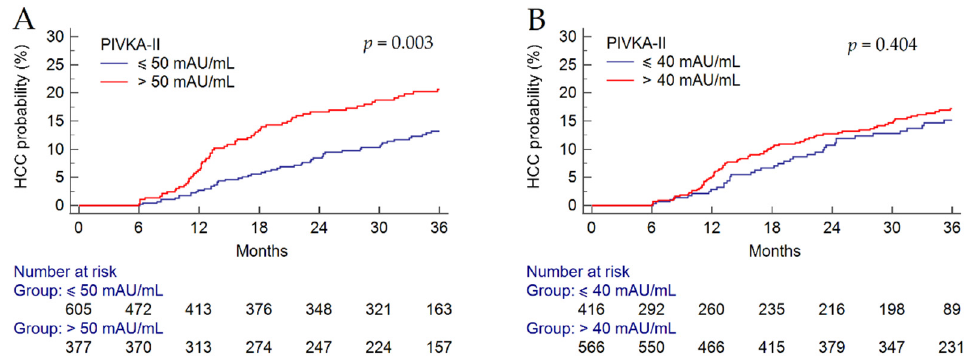
Figure 4. HCC incidence in patients with cirrhosis according to baseline serum PIVKA-II > 50 mAU/mL ( A ) and >40 mAU/mL ( B ). Abbreviations: HCC, hepatocellular carcinoma; PIVKA-II, protein induced by vitamin K absence or antagonist